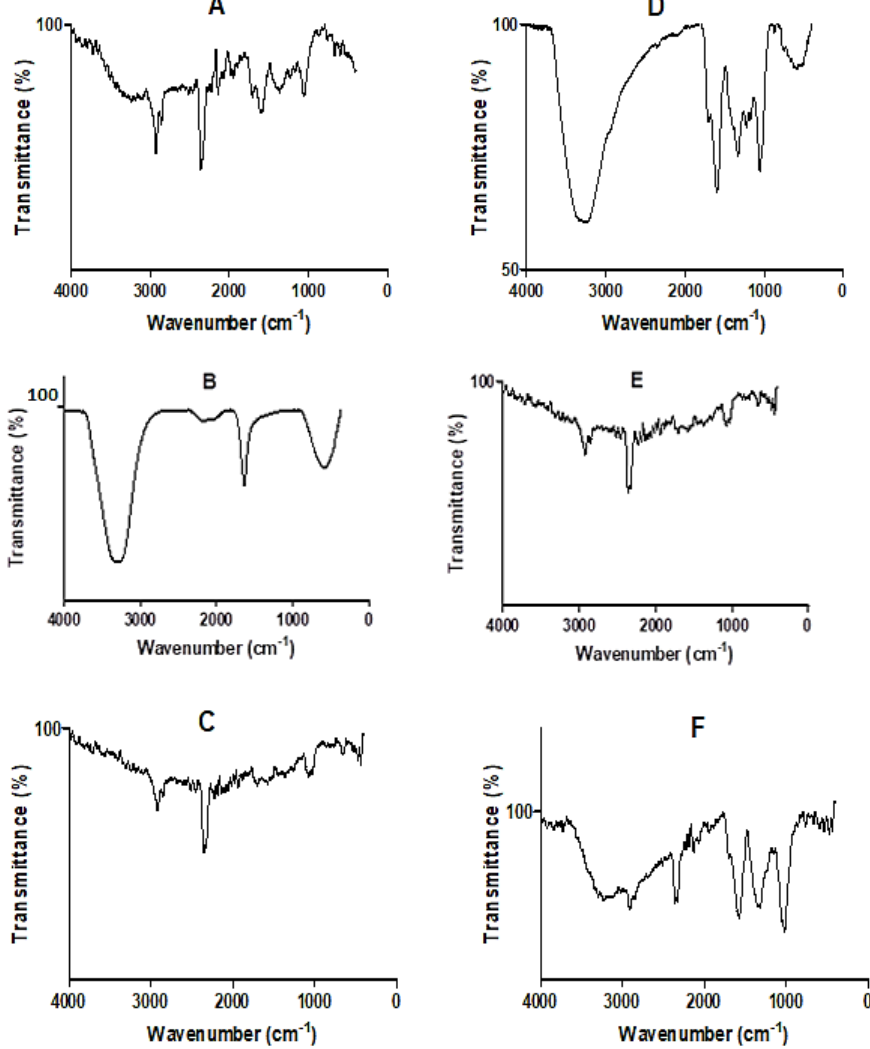
Figure 3. FT-IR spectra of crude extracts and the biosynthesized AgNPs of D. villosa plant. ( A ) Crude aqueous leaf extract; ( B ) leaves AgNPs synthesized at room temperature (LRT); ( C ) leaves AgNPs synthesized at 80 °C (L80); ( D ) crude aqueous stem bark extract; ( E ) stem bark AgNPs synthesized at room temperature (SRT); and ( F ) stem bark AgNPs synthesized at 80 °C (S80).